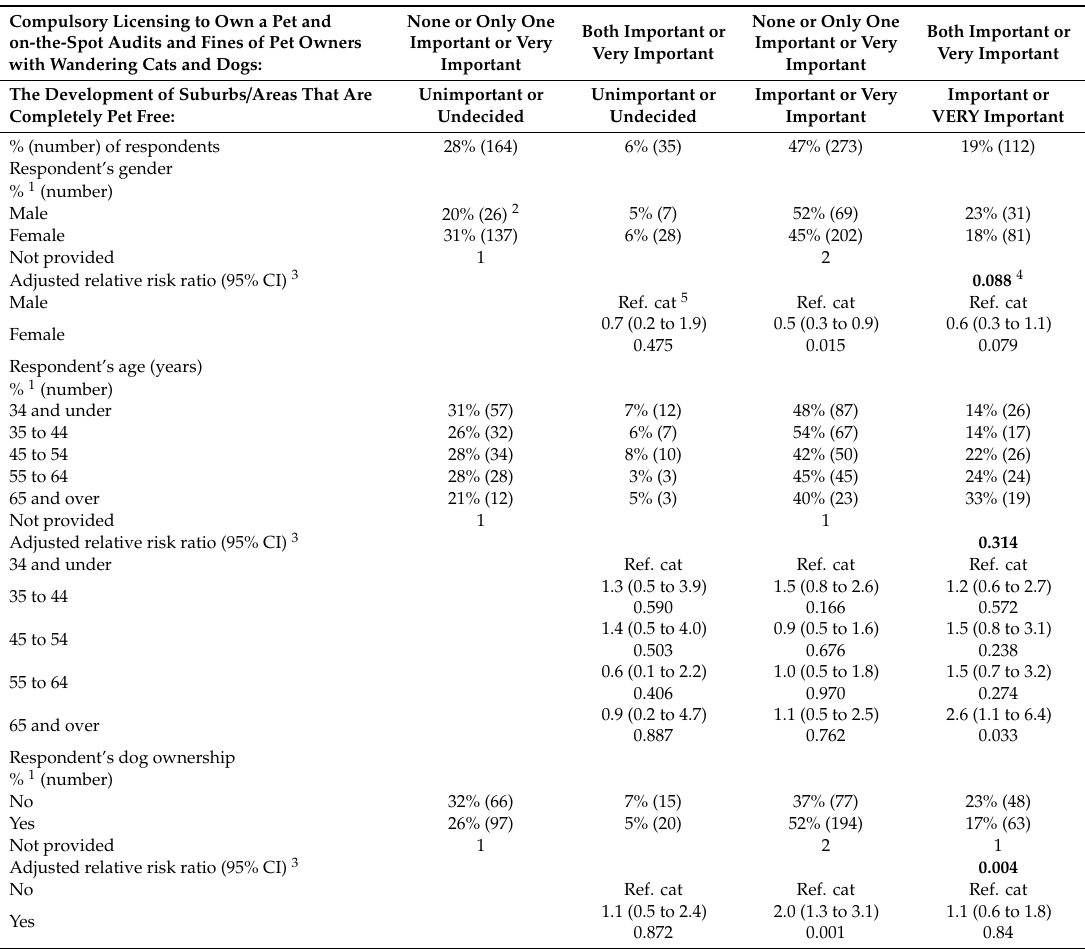
Table 10. Associations between socio-demographic variables (independent variables) and respondents’ collective views about the importance of strategies for controlling domestic (owned) dogs and cats. Each respondent was classified into one of four dependent variable categories based on their views about the importance of (a) compulsory licensing to own a pet and on-the-spot audits and fines of pet owners with wandering cats and dogs, and (b) the development of suburbs / areas that are completely pet free ( n =